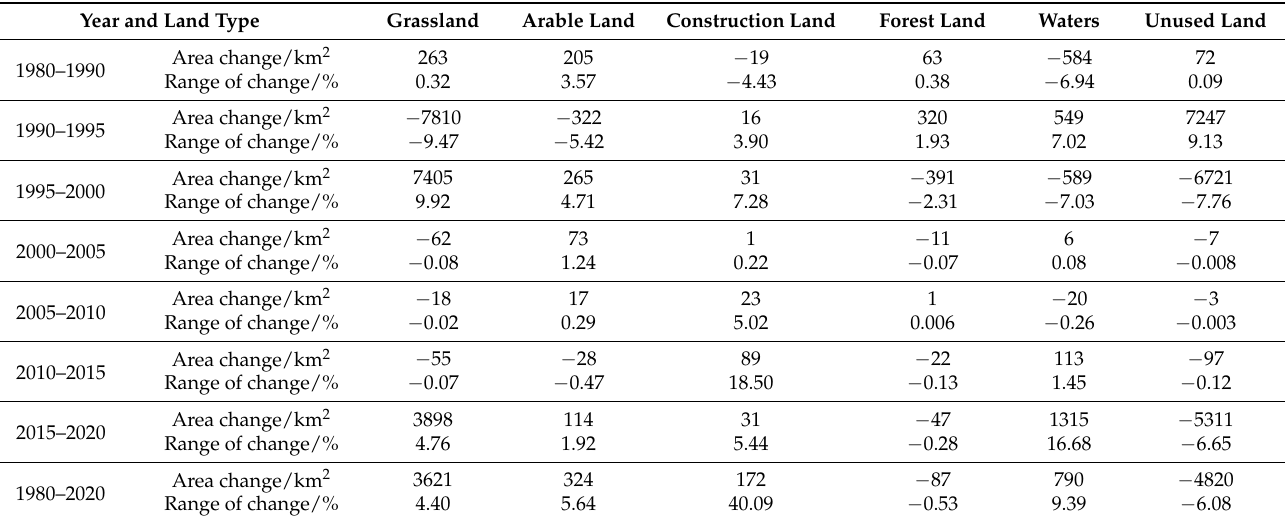
(unused land), 5.64% (arable la nd), 4.40% (grassland), and −0.53% (forest land). It can be seen that among the increased land-use type areas, the largest increase was in construction land; among the decreased land-use type areas, the largest decrease was the unused land. Table 3. Land use area changes in the Qilian Mountains from 1980 to 2020.